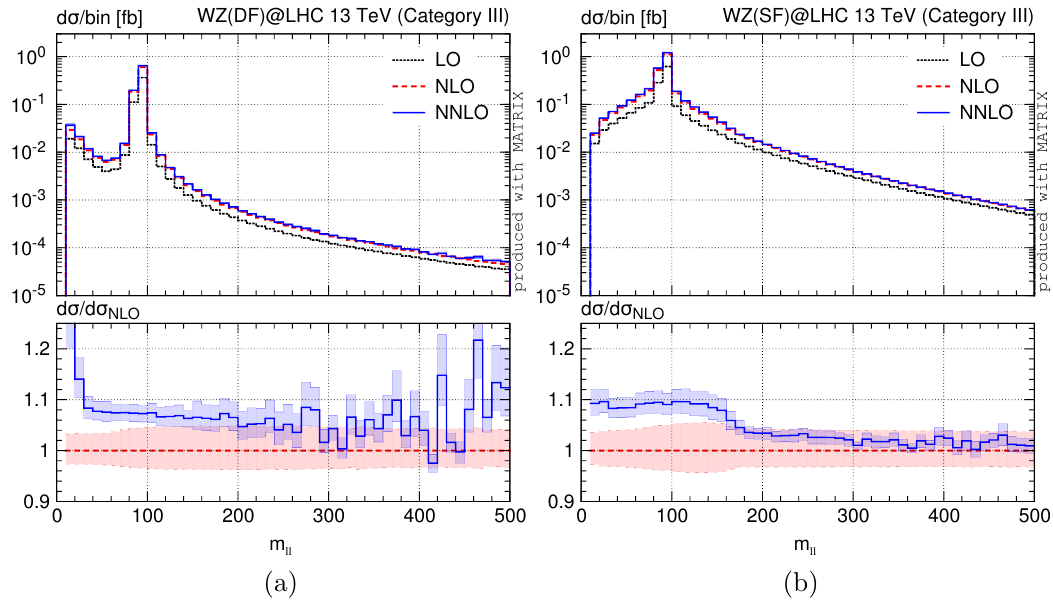
Figure 17 . Distributions with respect to m ‘‘ in the (cid:12)ducial phase space with an additional m T;W > 120 GeV cut (Category III), for (a) the SF and (b) the DF channel.